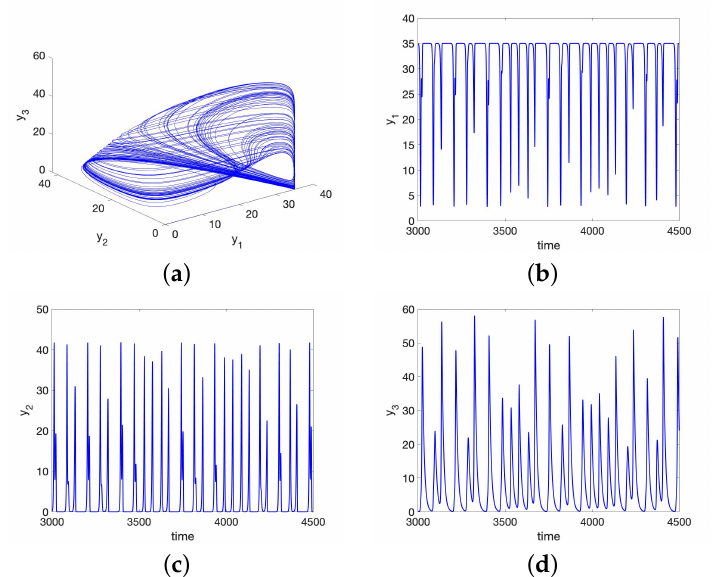
Figure 4. Chaotic dynamics with small initial data [ y 1 ( 0 ) , y 2 ( 0 ) , y 3 ( 0 )] = [ 0.01,0.01,0.01 ] in HP model. ( a ) Phase diagram showing chaotic attractor in HP model. ( b ) Time series plot for y 1 . ( c ) Time series plot for y 2 . ( d ) Time series plot for y 3